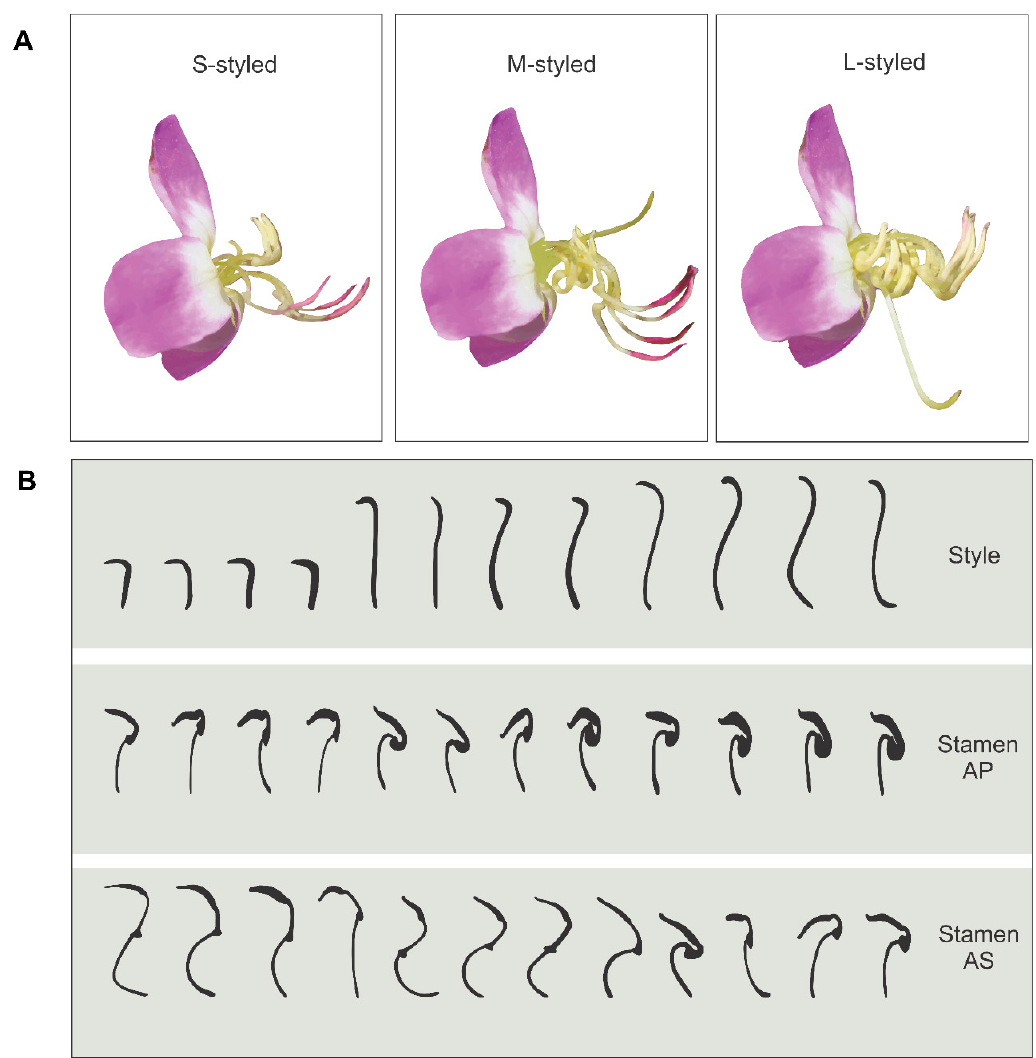
Figure 1. Typical floral types of Macairea radula . ( A ) Short-styled plants present flowers with short styles and two longer stamen sets, medium-styled plants present flowers with intermediate styles in relation to both stamen sets, and long-styled plants present flowers with styles longer than the two sets of stamens. ( B ) Scheme showing the variation in the length of sexual organs of each floral type. Each column corresponds to a flower (scale = 4 mm). AP means antepetalous stamens and AS means antesepalous stamens.